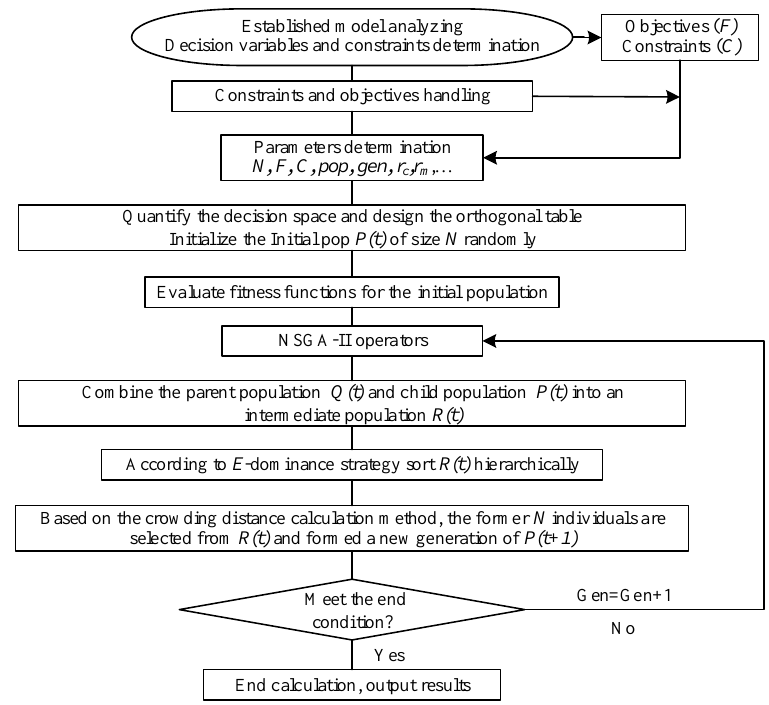
Figure 2. Flow chart of non-dominated sorting genetic algorithm (NSGA-II) based on the orthogonal generation method and the E-optimality method